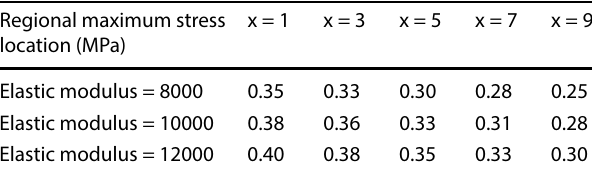
Table 4 Dry shrinkage stress for different elastic modulus(MPa) Regional maximum stress location (MPa)